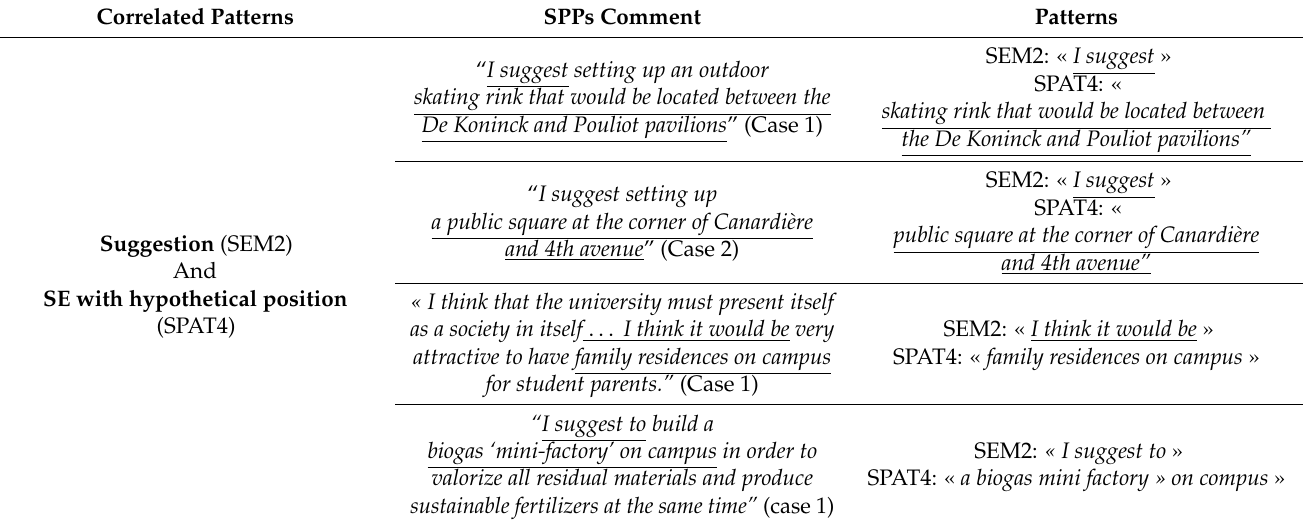
Table A8. Correlations detected between patterns.